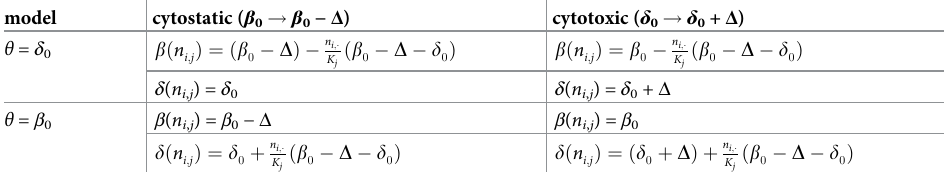
Table 2. Treatment effects. The birth and death rates under treatment depend on whether the carrying capacity is implemented via increasing death rate ( θ = β 0 ) or decreasing birth rate ( θ = δ 0